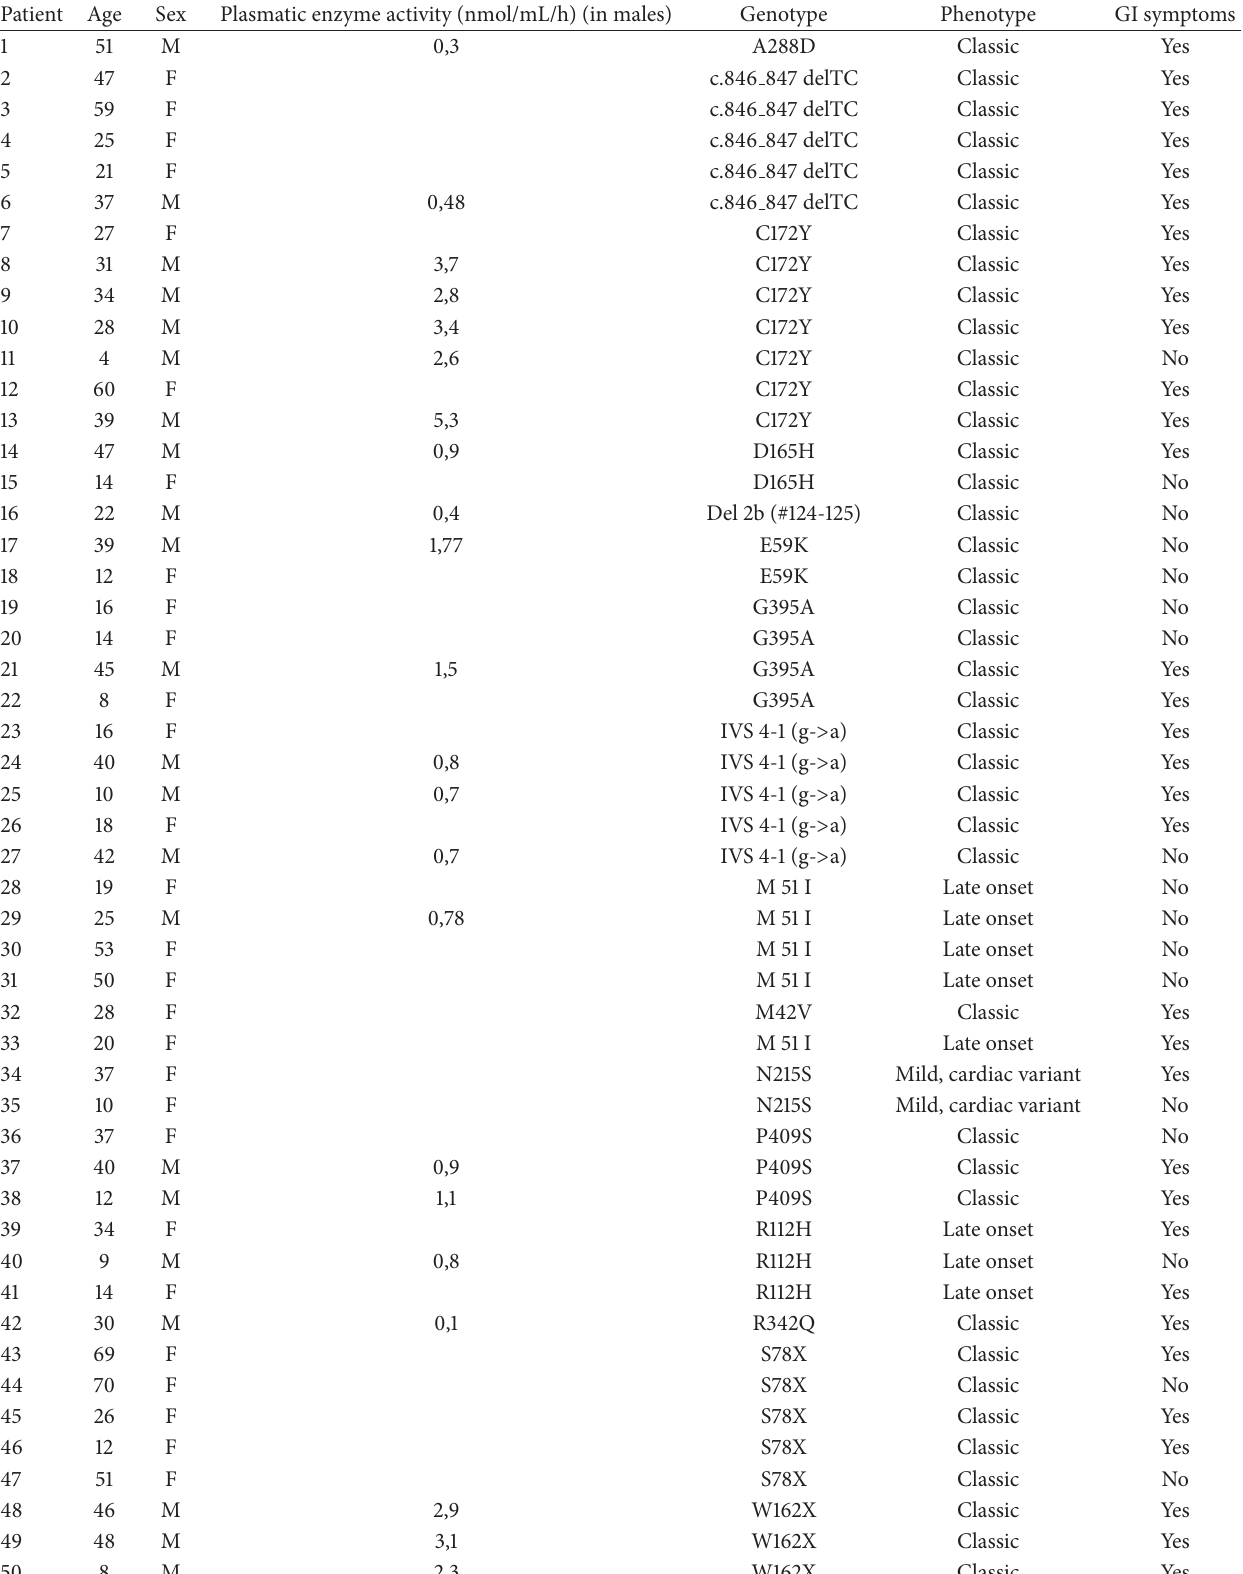
Table 1: Phenotype, genotype, enzyme activity, and clinical details of 50 patients with Fabry disease. Patient Age Sex Plasmatic enzyme activity (nmol/mL/h) (in males)